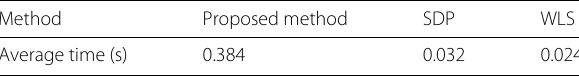
Table 3 Calculation time for three compared methods